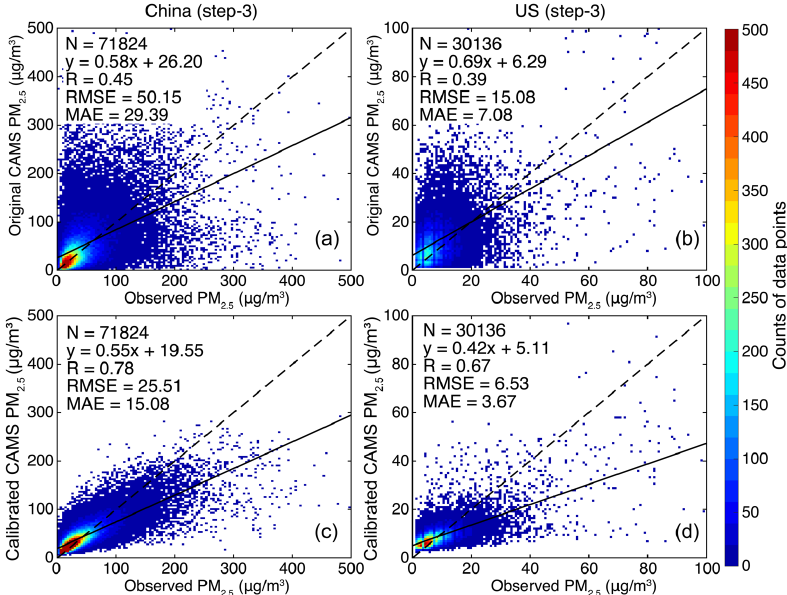
Figure 6. Comparison of the cross-validation accuracy between the original ( a , b ) and the calibrated ( c , d ) PM 2.5 forecasts with a forecasting time horizon of 3 h (step-3). Note the data values compared here were unseen data which were randomly selected and retained for the cross-validation